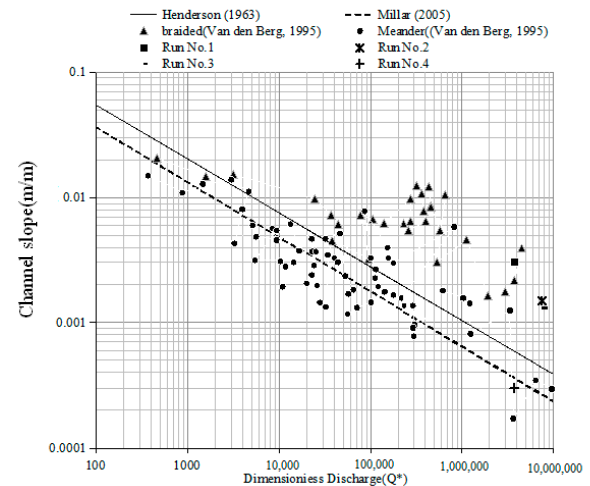
Figure 11. Dimensionless braid thresholds with the numerical experiment data.